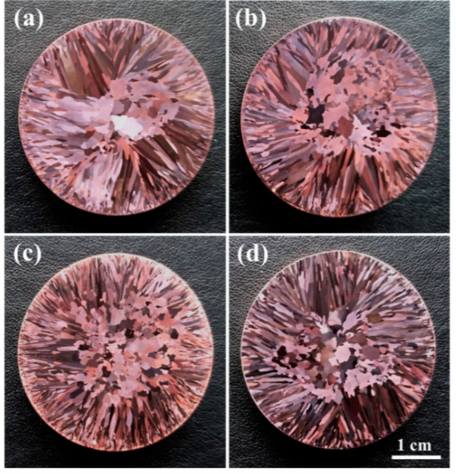
Figure 1. Cross-sectional macrostructures of ( a ) C00, ( b ) C01, ( c ) C05 and ( d ) C10 specimens, respectively.